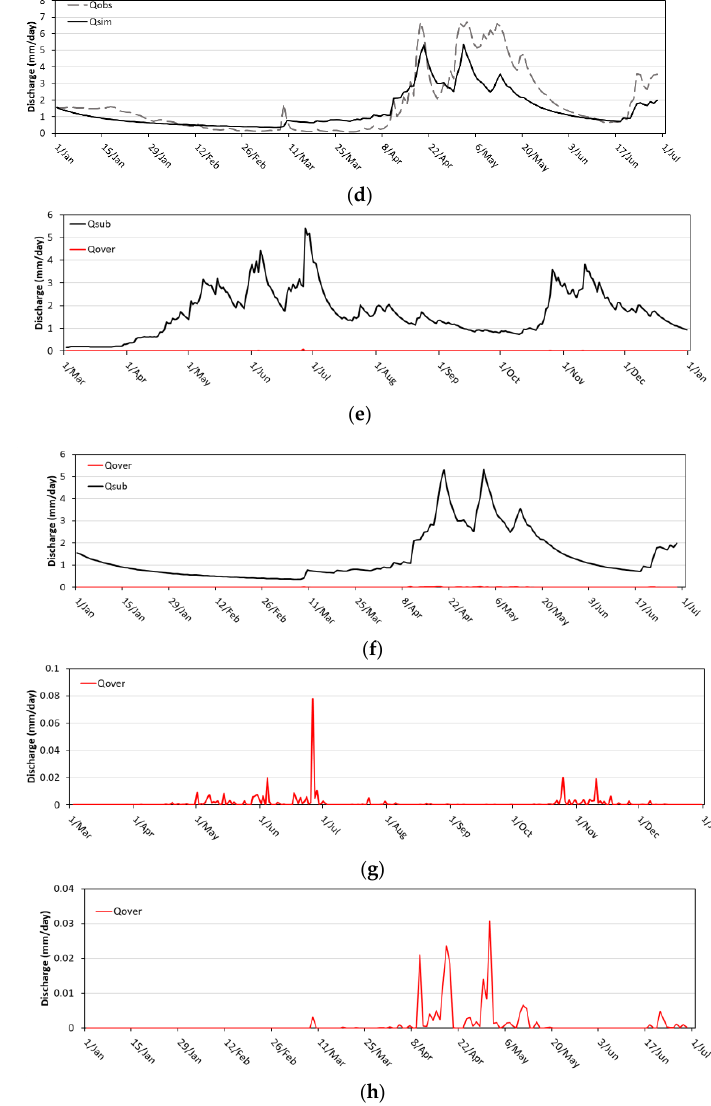
Figure 5. Observed rainfall, observed hydrograph and the hydrographs simulated by TOPMODEL. ( a ) Observed rainfall in 2015; ( b ) Observed rainfall in 2016; ( c ) Observed hydrograph and the hydrograph simulated during model calibration in 2015; ( d ) Observed hydrograph and the hydrograph simulated during model validation in 2016; ( e ) Hydrograph separation in 2015 during model calibration. Note that the overland flow was too small to be represented on this graph; ( f ) Hydrograph separation in 2016 during model validation. Note again that the overland flow was too small to be detected on this graph; ( g ) Overland flow prediction in 2015 during model calibration; and ( h ) Overland flow prediction in 2016 during the model validation period. Q obs (observed discharge); Q sim (simulated discharge); Q over (overland flow); Q sub (subsurface flow). From Figure 6, all parameters–except m and t d –showed good (and bad) simulations over the whole range of the parameter space. As the NSE value increased, m and t d occupied a narrower zone in the parameter space.